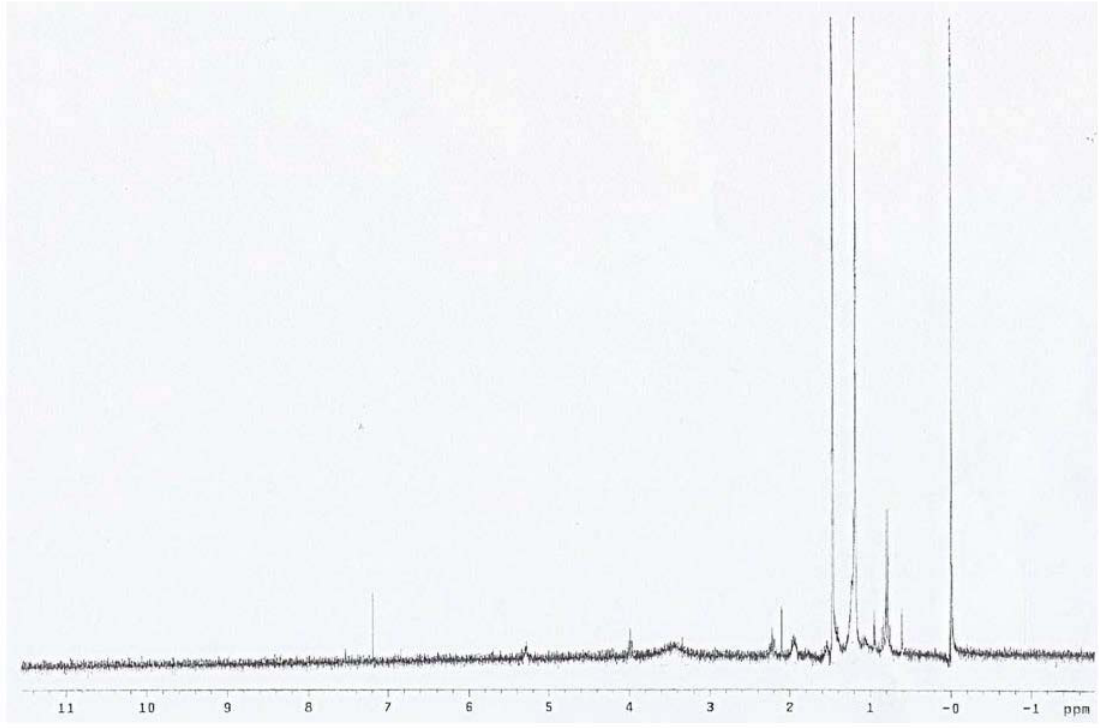
Figure 2. A 300 MHz NMR spectrum of meibomian expression. The signal above 0 ppm indicates the TMS